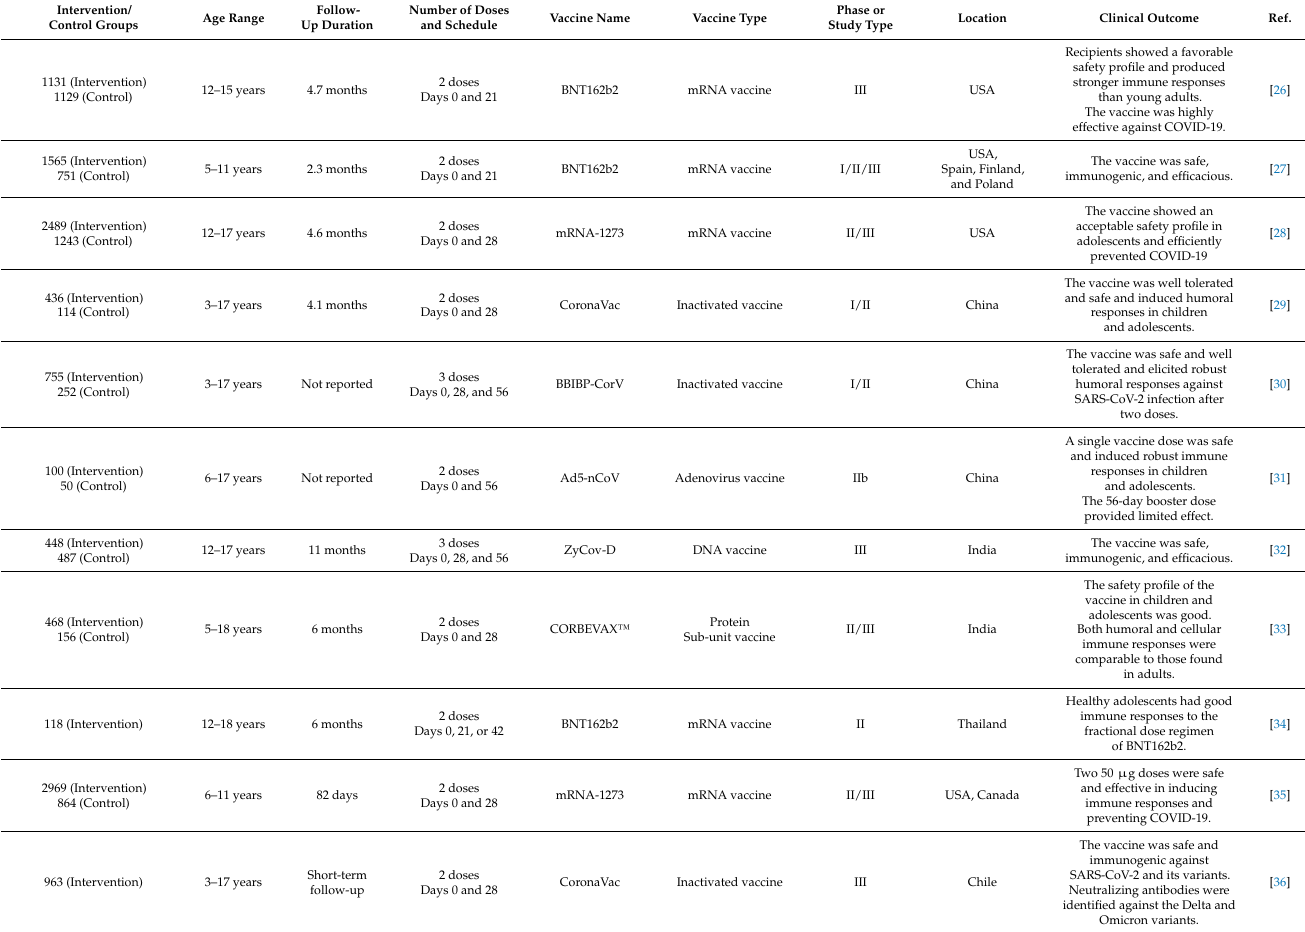
Table 1. Clinical trials on safety and efficacy of COVID-19 vaccines in children and